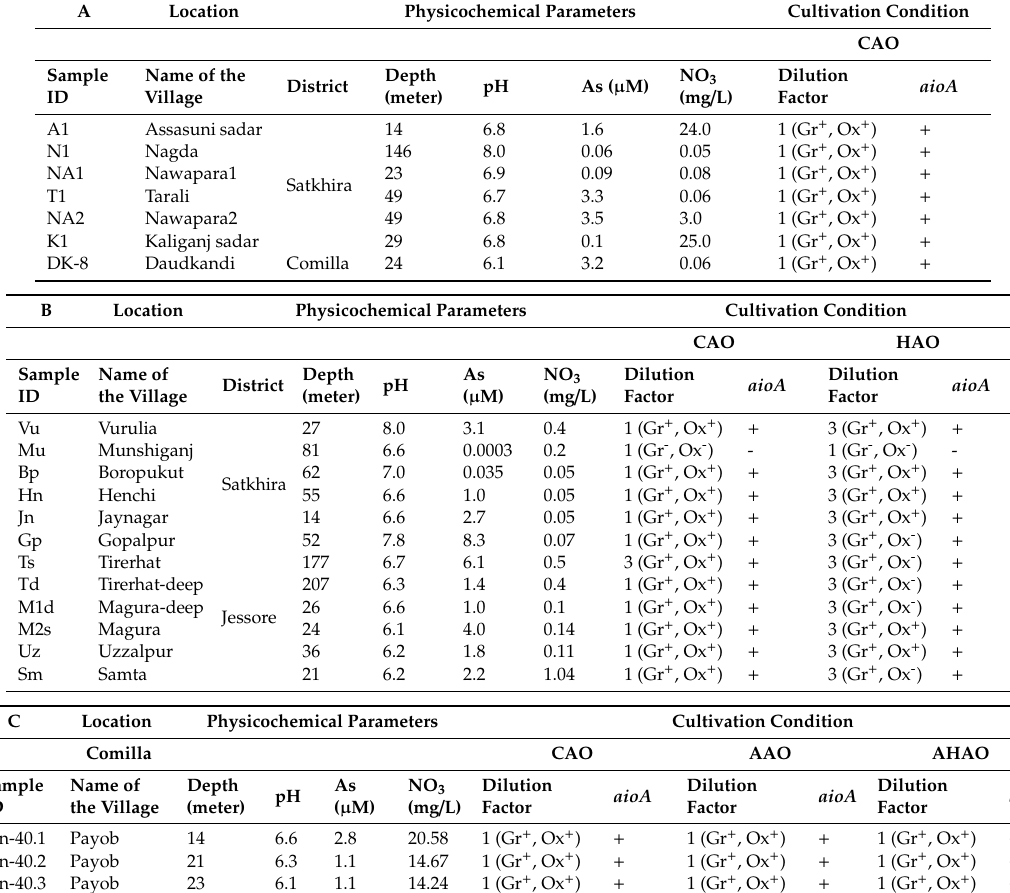
Table 1. Cultivation of arsenite-oxidizing microorganisms initiated from twenty-two drinking water wells in Bangladesh (indicated by sample code or ID, name of the village in which the well is located, district, well depth and physicochemical parameters). Table 1A showed CAO cultivation condition of 6 villages in the Satkhira district and one more village (DK8) in the Comilla district. Table 1B showed CAO and HAO cultivation condition of 6 more villages in the Satkhira district (Vu, Mu, Bp, Hn, Jn, and Gp), plus 6 villages in the Jessore district (Ts, Td, M1d, M2s, Uz, Sm). Table 1C showed CAO, AAO and AHAO cultivation condition of three villages in the Comilla district. The column ‘dilution factor’ presents the highest serial tenfold dilution (e.g., 10 − 1 , 10 − 2 and 10 − 3 ) at which growth was still observed. Subsequent columns indicate the results of molecular searches for specific functional genes indicative of potential for arsenite biotransformation, i.e., aioA (arsenite oxidase gene): + : detected, -: not detected; Gr +/ - : positive / negative microbial growth and Ox +/ - : positive / negative microbial arsenite